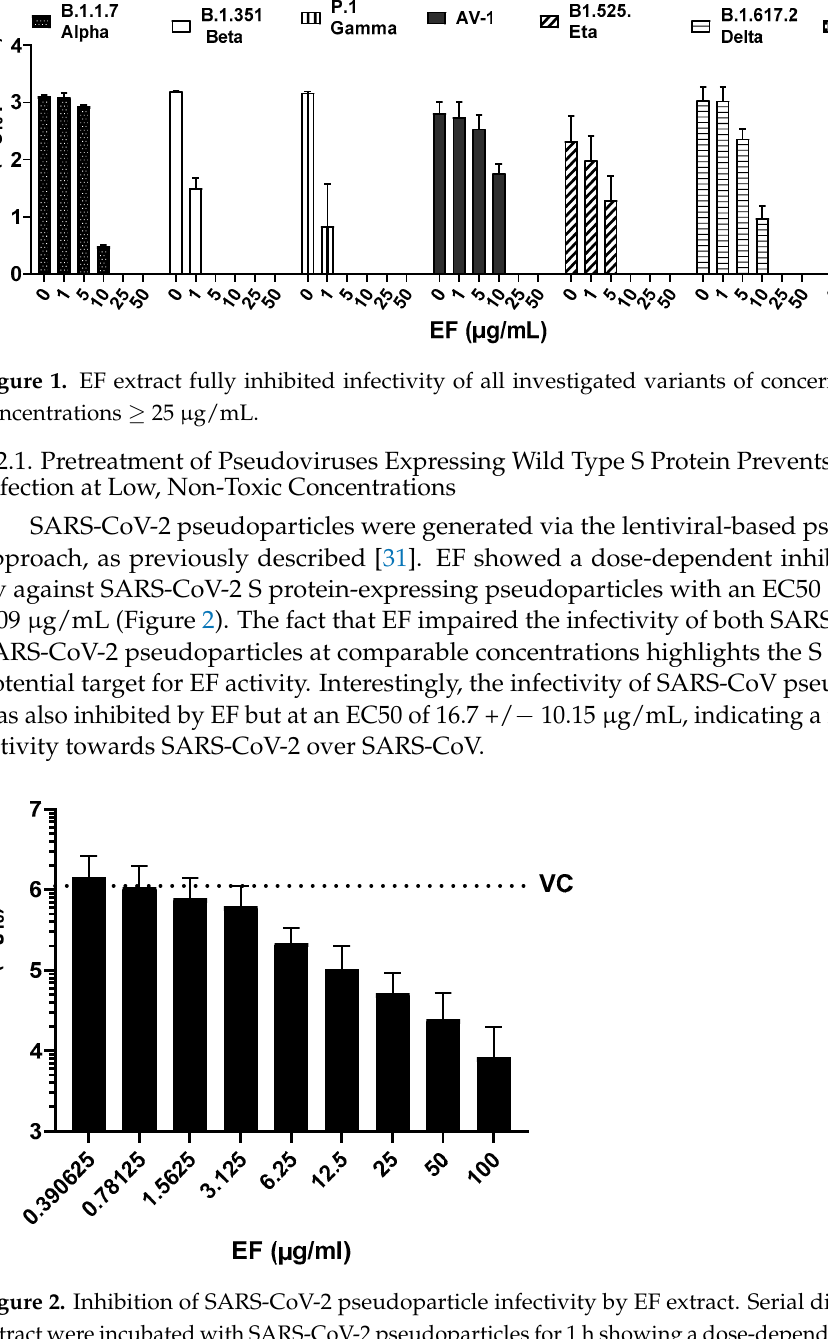
Figure 2. Inhibition of SARS-CoV-2 pseudoparticle infectivity by EF extract. Serial dilutions of EF extract were incubated with SARS-CoV-2 pseudoparticles for 1 h showing a dose-dependent inhi- bition of SARS-CoV-2 infectivity as measured by intracellular luciferase expression in mean relative light units (RLU). VC represents the RLU value of SARS-CoV-2 pseudoparticles-infected untreated cells. Data represent mean values ± standard deviations from three independent experiments per- formed in quadruplicates per